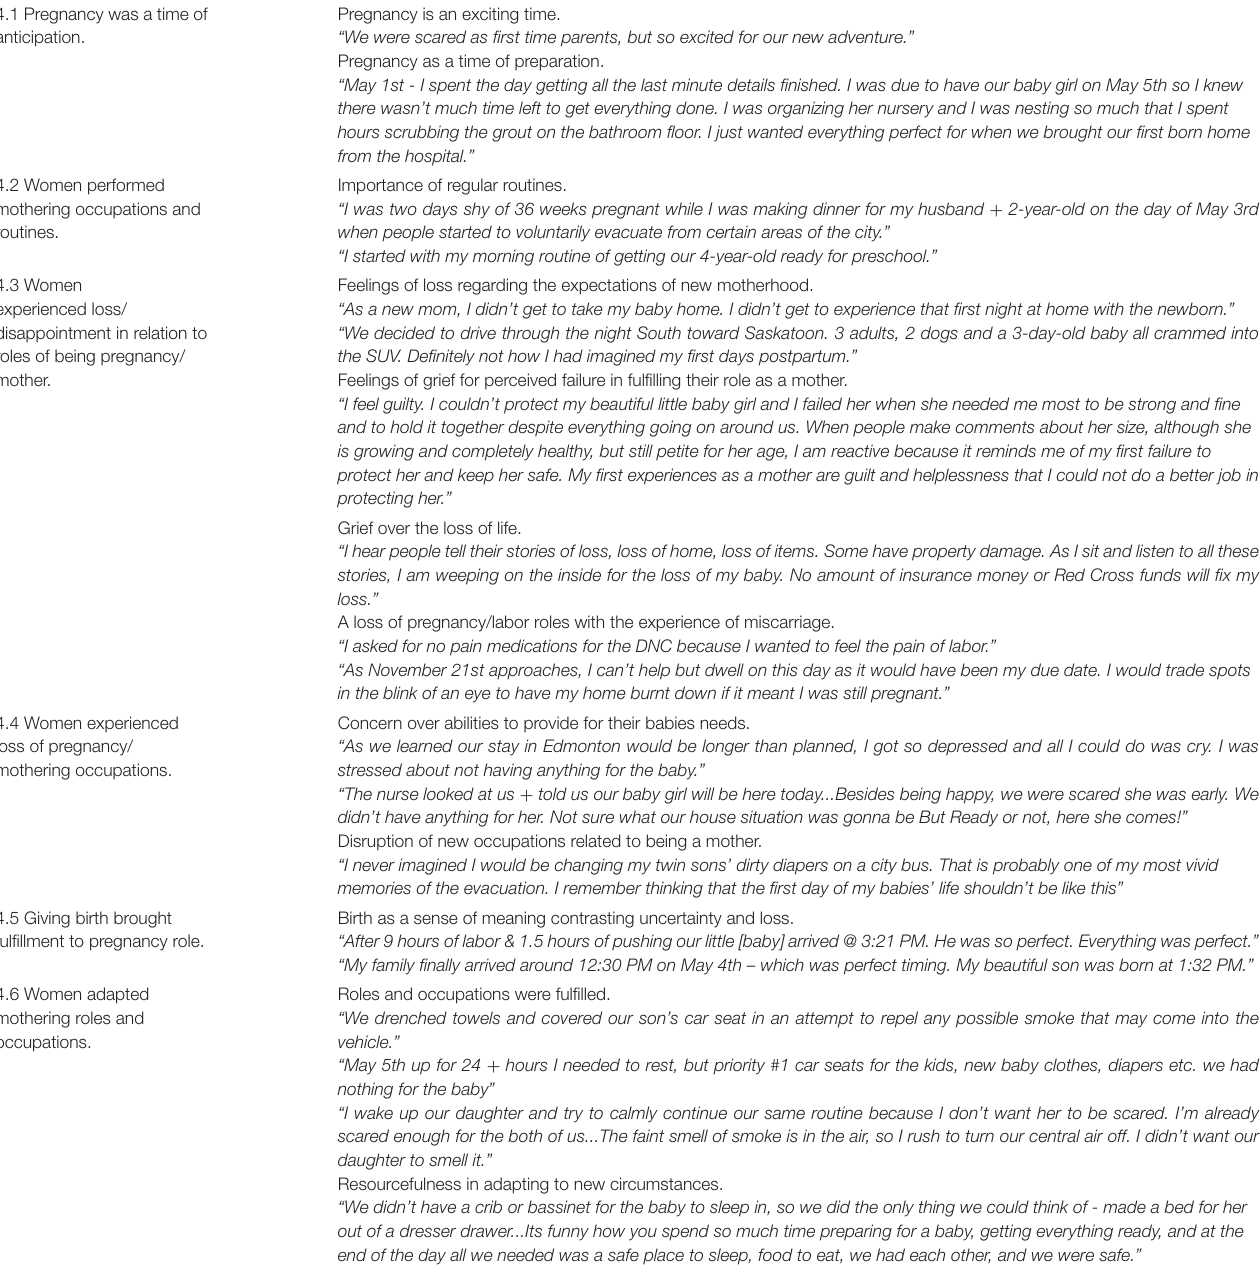
TABLE 4 | Theme 4: The roles of pregnancy and motherhood in the experiences of loss and resilience.